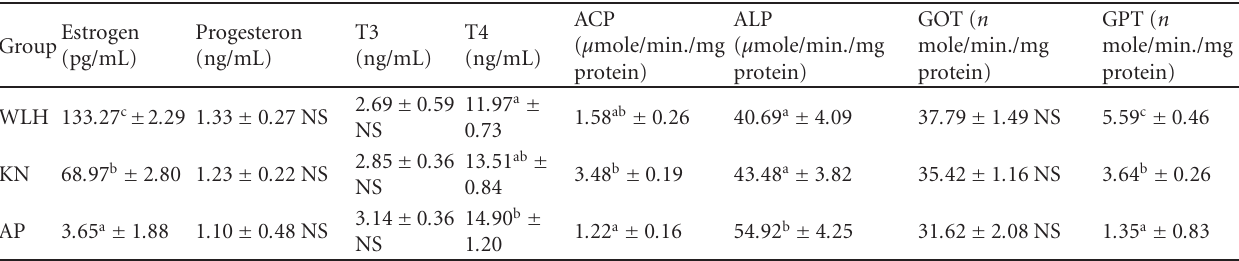
Table 3: Age-dependent variation in hormonal concentration and biochemical constituents of blood plasma (18thwk) in di ff erent breeds of Indian native hen (mean ± S.E.M, n = 6).